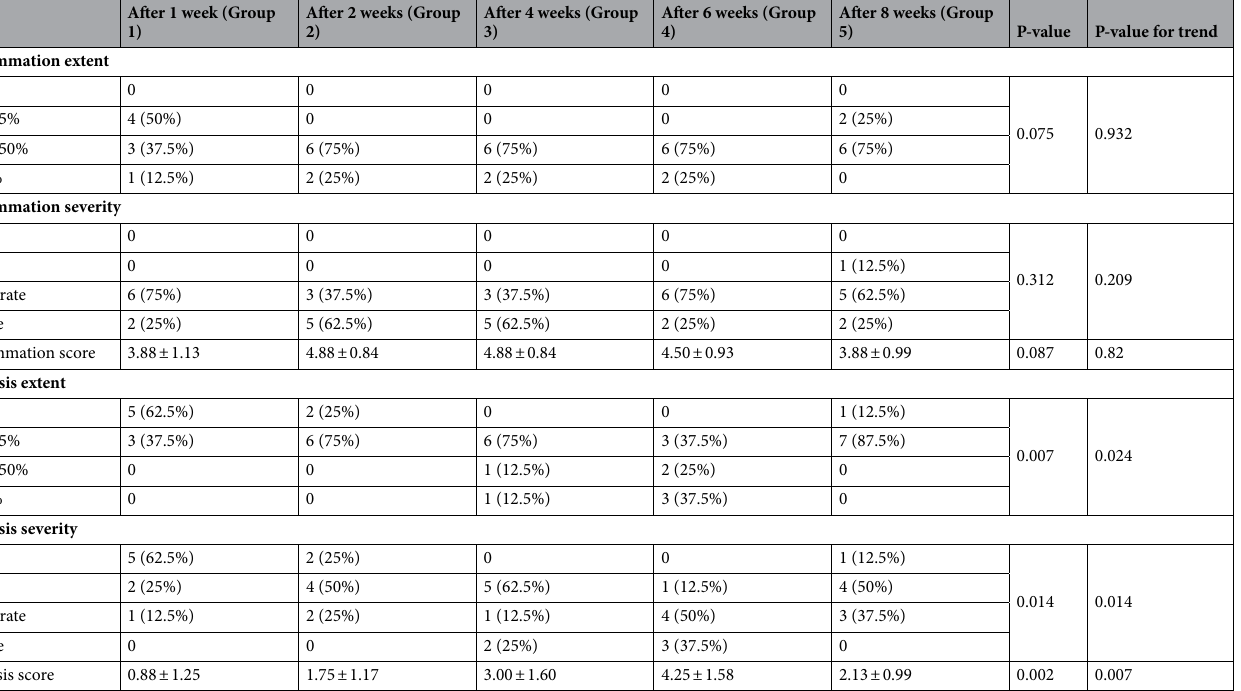
Table 4. The extent and severity of inflammation and fibrosis according to the